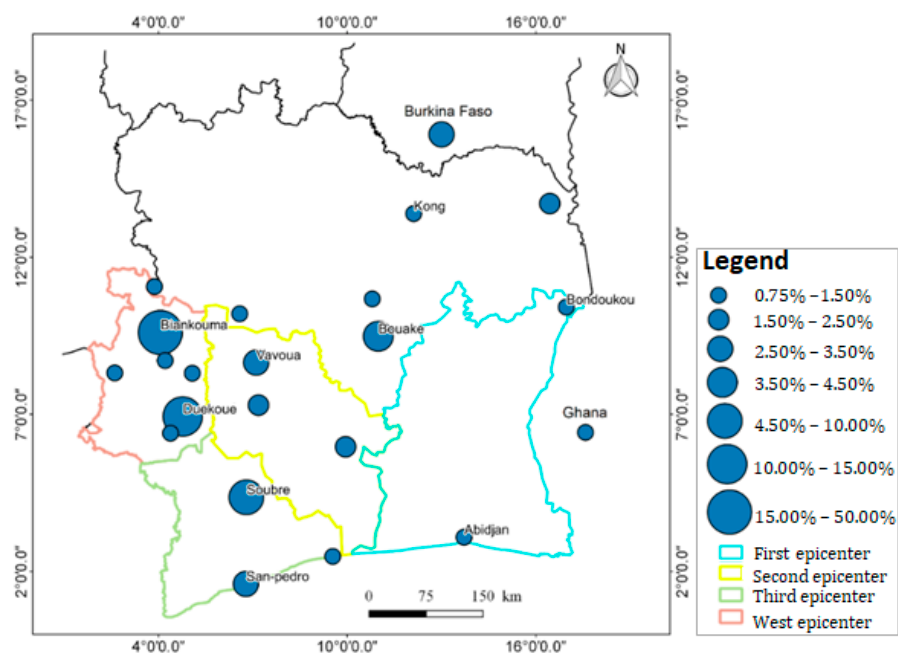
Figure 10. Place of origin of cocoa farmers in Biankouma region.